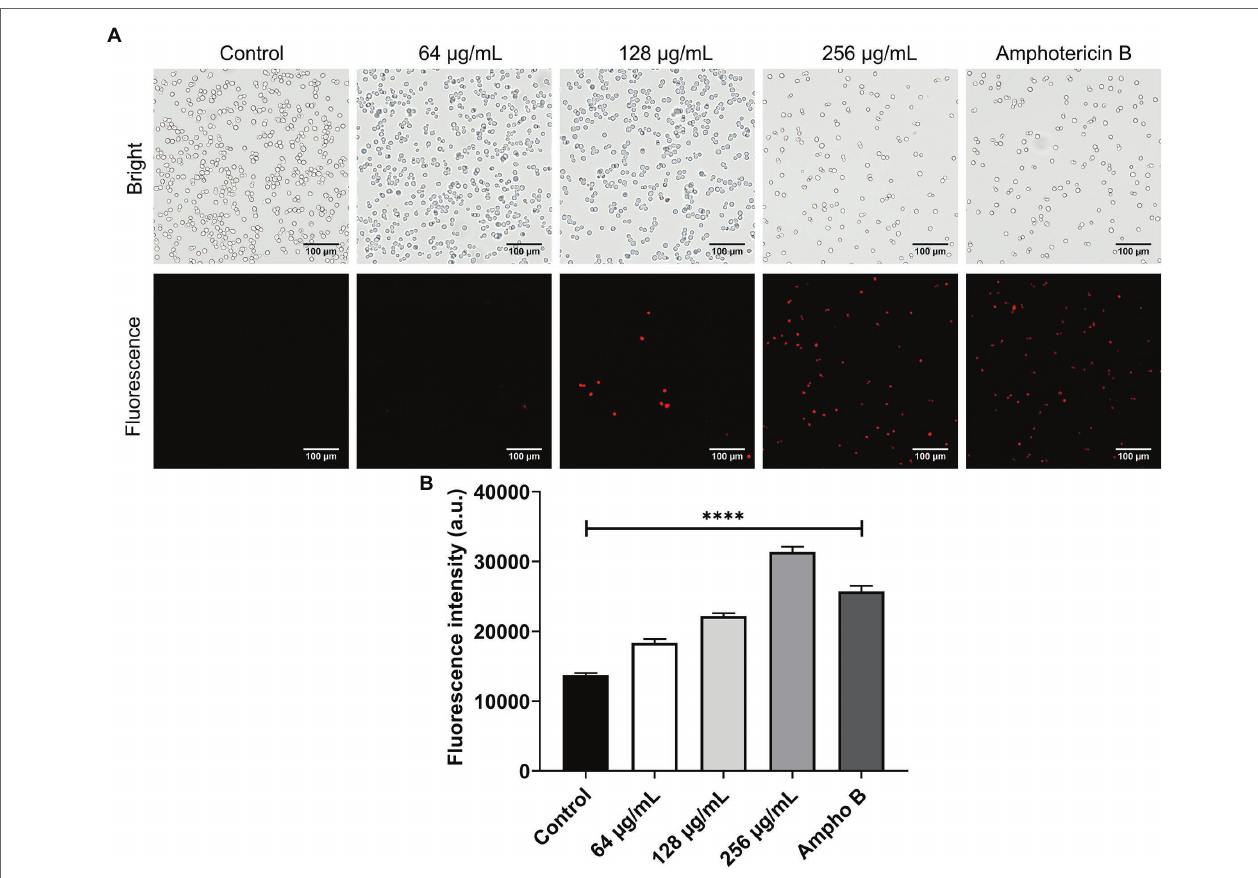
FIGURE 6 | Alteration of the cell membrane of Candida albicans in β -citronellol treatment. Yeast cells (1 × 10 6 cells/ml) were treated with β -citronellol and amphotericin B (2 μ g/ml) for 4 h. (A) Morphology of yeast cells under bright field and fluorescence microscope. (B) Red fluorescence intensity of the DiBAC 4 (3) probe at excitation/emission wavelength 492/518 nm. Data are represented as mean ± SD. **** p ≤ 0.0001 compared to the